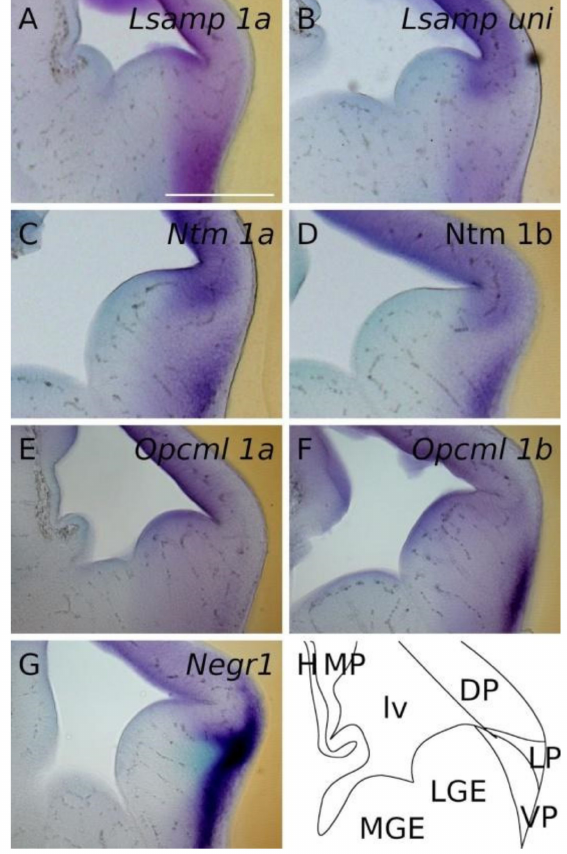
Figure 3. In situ mRNA hybridization displaying IgLON members in developing pallium. ( A – G ) Expression of IgLON probes recapitulating alternative promoter activity in pallial divisions at E13.5 mouse embryo. ( H ) scheme of cutting planes. Abbreviations: DP, dorsal pallium; LP, lat- eral pallium; VP, ventral pallium; MP, medial pallium; lv, lateral ventricle; LGE, lateral ganglionic eminence; MGE, medial ganglionic eminence; Lsampuni, Lsamp 1a + 1b . Scale bar: 500 µ